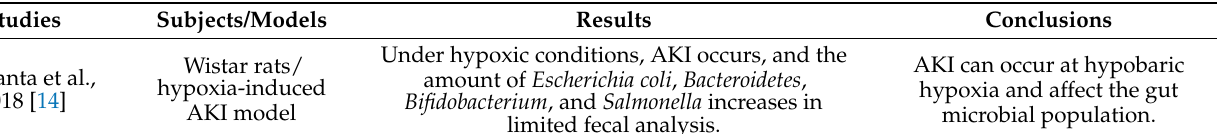
Table 1. Studies evaluating the association between AKI and gut